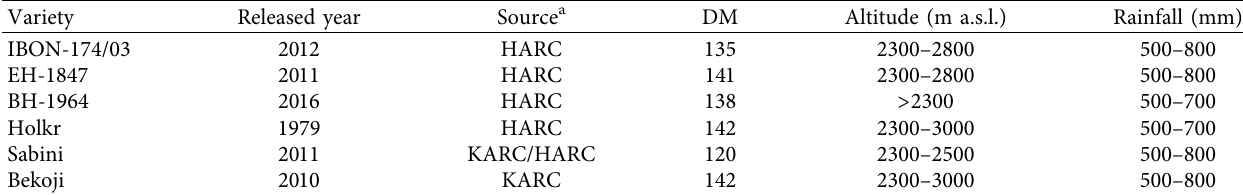
Table 2: Description of malt barley varieties used for the study.